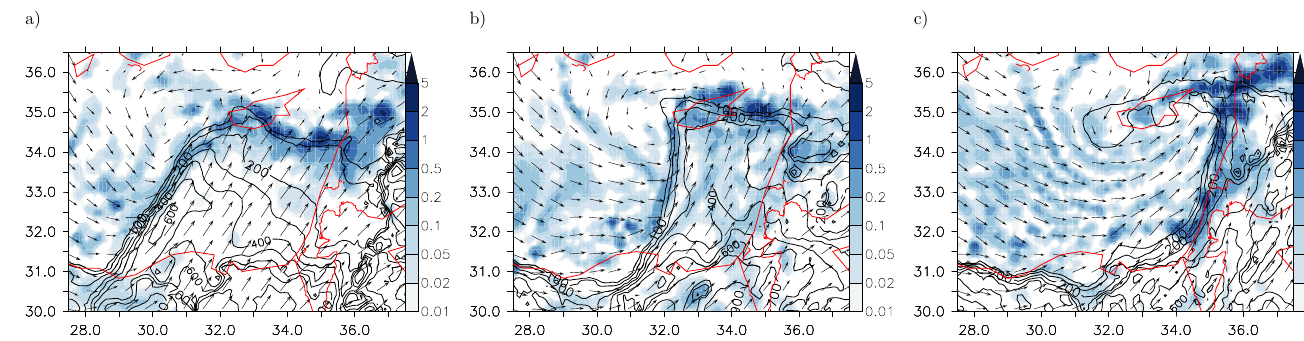
Fig. 3. Column burden of the mixing ratios of integrated total condensate (kgm − 2 ) on 28/29 January 2003 at 12:00UTC (a) , 18:00UTC (b) and 03:00UTC (c) for scenario τ 1 . Contour lines show dust concentrations (µgm − 3 ) at 500m altitude.